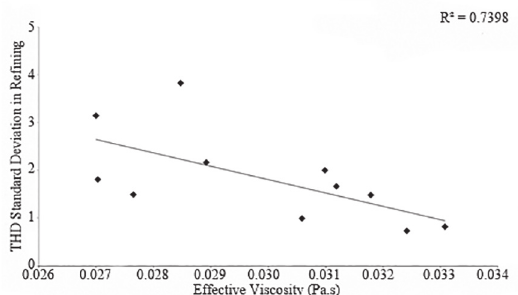
Figure 10: Relationship between effective viscosity calculated and THD standard deviation.